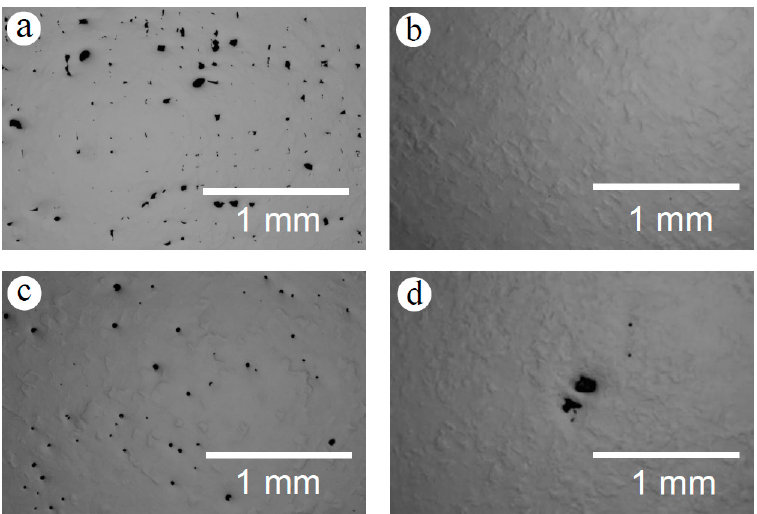
Figure 6. OM (Optical Microscope) micrographs of the polished surface of the as-built Zr-1Mo alloys with various scanning speeds: ( a ) 1200 mm·s − 1 , ( b ) 1050 mm·s − 1 , ( c ) 600 mm·s − 1 , ( d ) 1200 mm·s − 1 , and energy densities: ( a ) 26.4 J·mm − 3 , ( b ) 48.3 J·mm − 3 , ( c , d ) 84.4 J·mm − 3 .